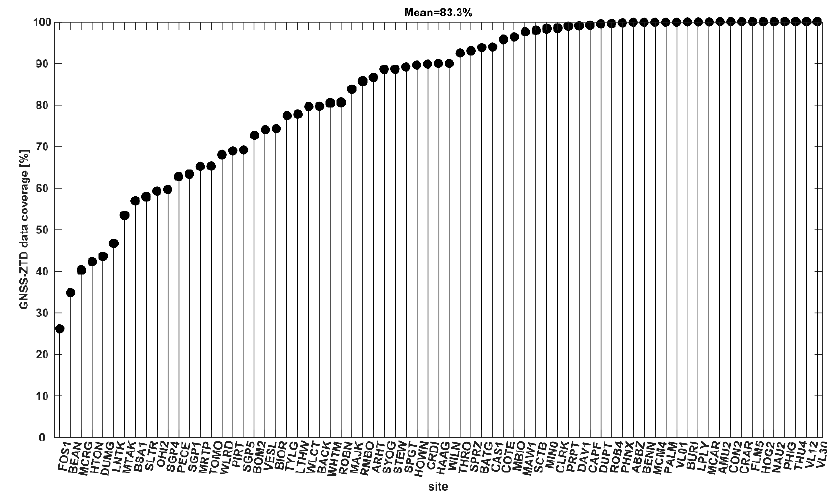
Figure 2. Data coverage of GNSS_ZTD from 1 January 2018 to 23 October 2021.